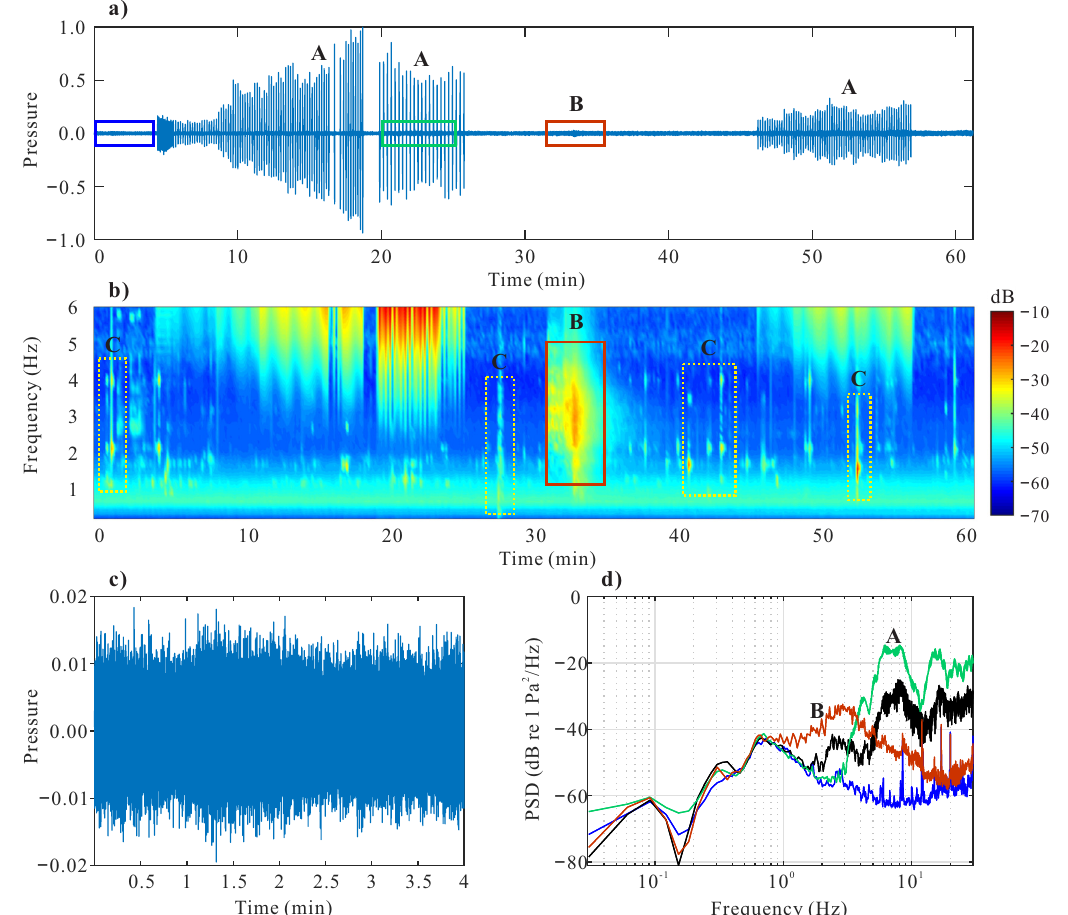
Figure 2. Temporal and spectral analysis. Letters A, B and C denote different events detected. ( a ) the pressure recorded at one receiver. The pressure is normalized by the maximum amplitude. The blue box selects a window where the noise is not affected by severe events. The green box selects a window where the noise is affected by Event A. The red box selects a window where the noise is affected by Event B; ( b ) the averaged PSD (dB re 1 Pa 2 /Hz) of all receivers as a function of time and frequency (spectrogram); ( c ) the enlarged view of the noise marked by blue box in ( a ); ( d ) the PSD of the corresponding noise marked by boxes in ( a ). The curves are related to the noise by the color of the boxes in ( a ). The black curve is the averaged PSD over 60